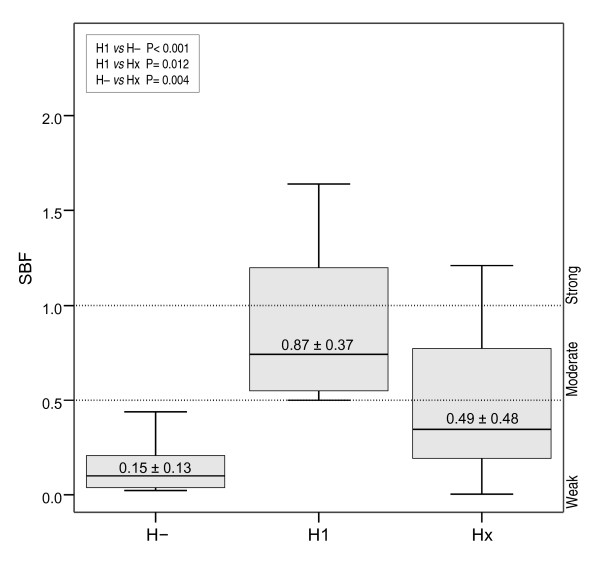
Mean SBF index of motile and nonmotile strains irrespectively of their AIEC phenotype. SBF indices were higher in motile strains, especially H1 serotypes, than nonmotile strains. H-: nonmotile strains; H1: motile and H1 flagellar type; Hx: motile and any flagellar type except for H1.